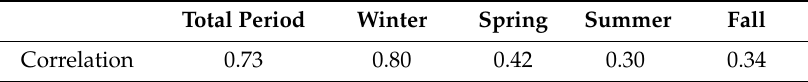
Table 5. PAH and n-Alkane concentration correlation.